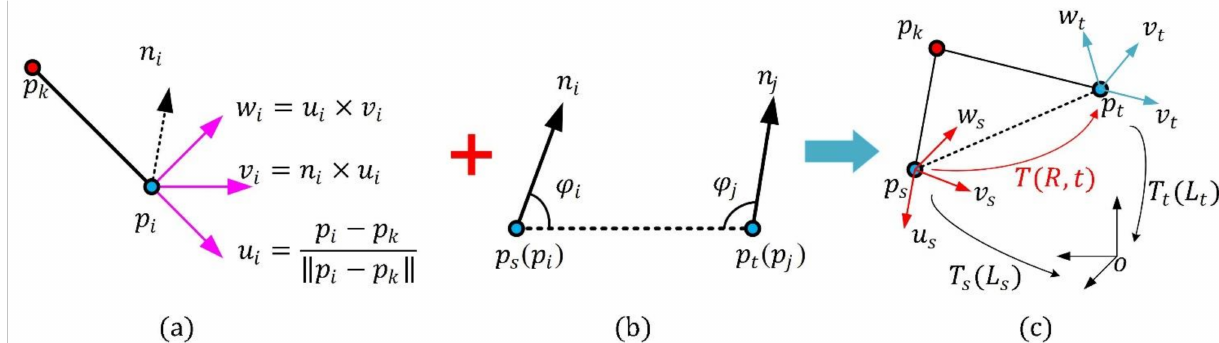
Figure 2. Generation of a point-pair transformation matrix. ( a ) Definition of proposed Darboux frame. ( b ) Definition of source point and target point. ( c ) Computation of point-pair transformation